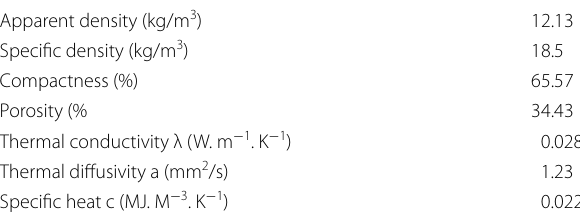
Table 2 Physical properties of polystyrene beads.